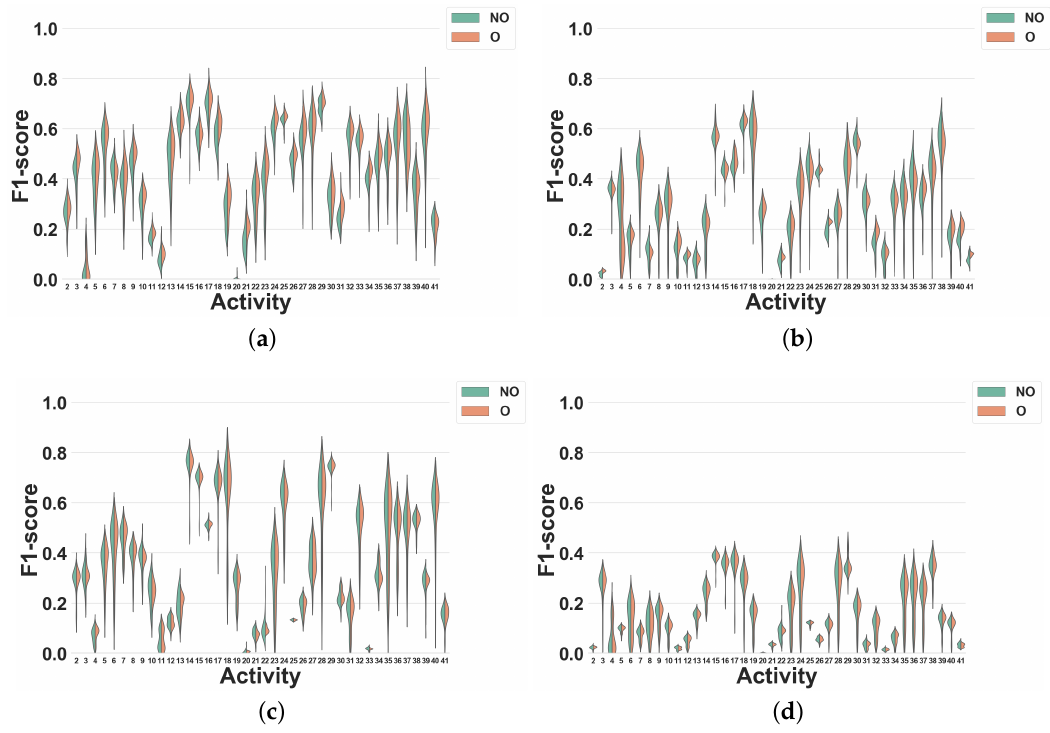
Figure 12. Experiment 4–Subject-independent CV–Dataset 2. ( a ) DT; ( b ) KNN; ( c ) NB; ( d )